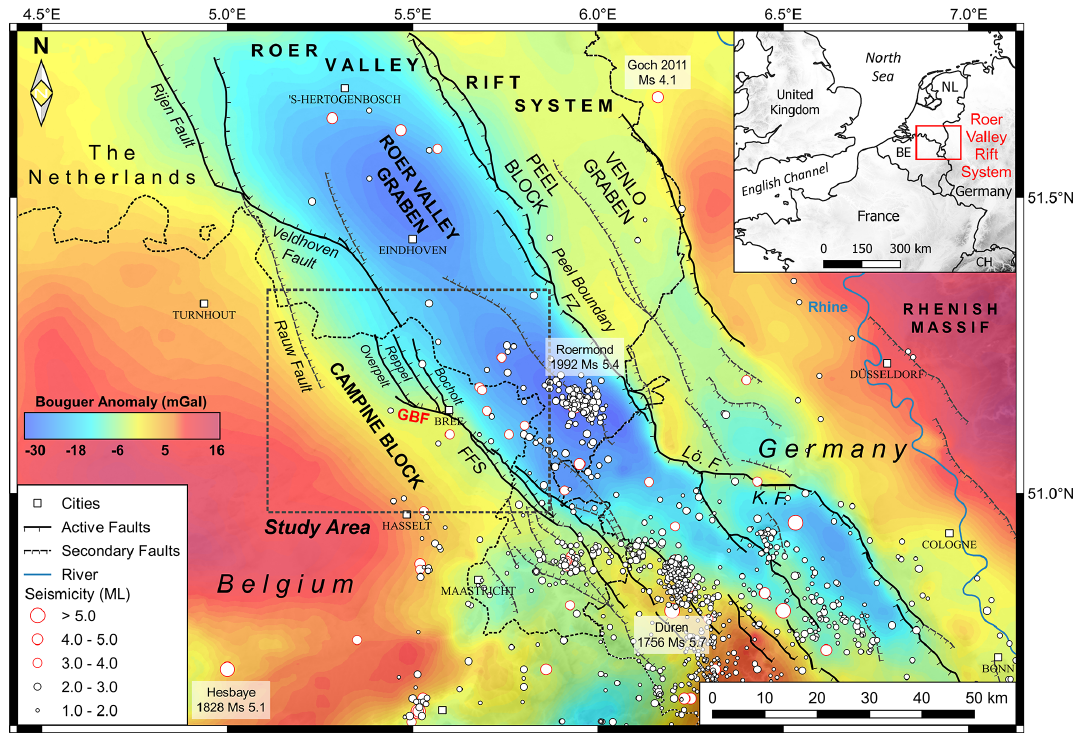
Figure 1. The Roer Valley rift system with its different tectonic blocks, border fault configuration, and seismicity in relation to the Bouguer anomaly. Note the lower Bouguer Anomaly values (Bouguer data gathered by the Royal Observatory of Belgium as described in Everaerts and De Vos, 2012, and Verbeurgt et al., 2019) in the Roer Valley graben related to the thick Cenozoic sequence of uncompacted sediments. The gray dashed square indicates the study area and the location of Figs. 3, 4, and 5. Lö. F.: Lövenich Fault; K. F.: Kast Fault. Surface fault traces modified after Vanneste et al. (2013) and Deckers et al. (2018). Historical and instrumental natural seismicity updated until December 2019 (Seismic catalog of the Royal Observatory of Belgium,